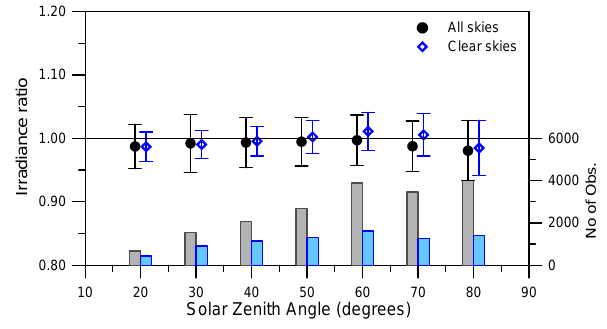
Fig. 10. Averages of the ratios (Brewer #086 over Brewer #005) of synchronous irradiance integrals (315–320nm) recorded by the two Brewer spectroradiometers as a function of solar zenith angle, in intervals of 10 ◦ , for clear-sky (rhombuses) and all-sky conditions (filled circles). The error bars correspond to one standard